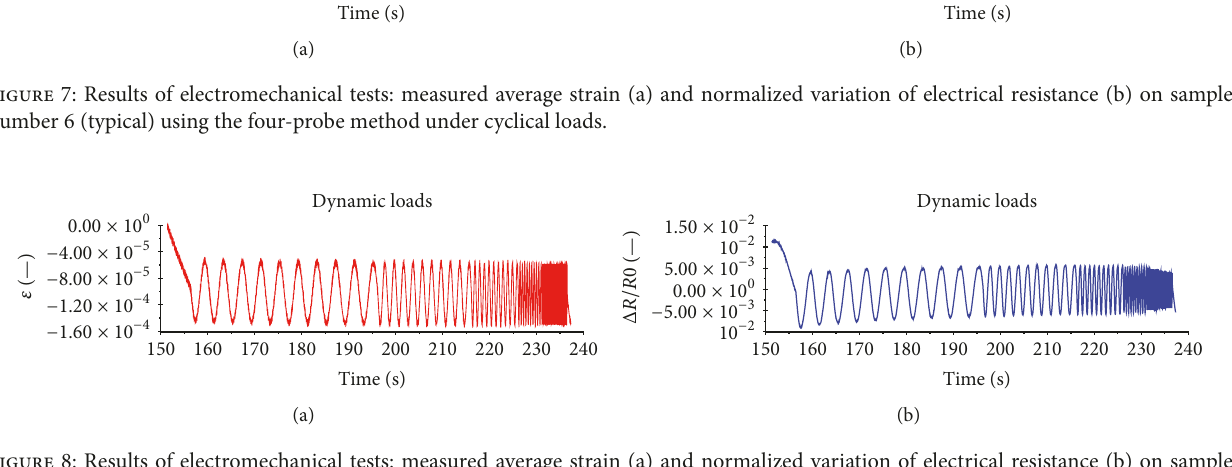
Figure 8: Results of electromechanical tests: measured average strain (a) and normalized variation of electrical resistance (b) on sample number 6 (typical) using the four-probe method under dynamic loads.